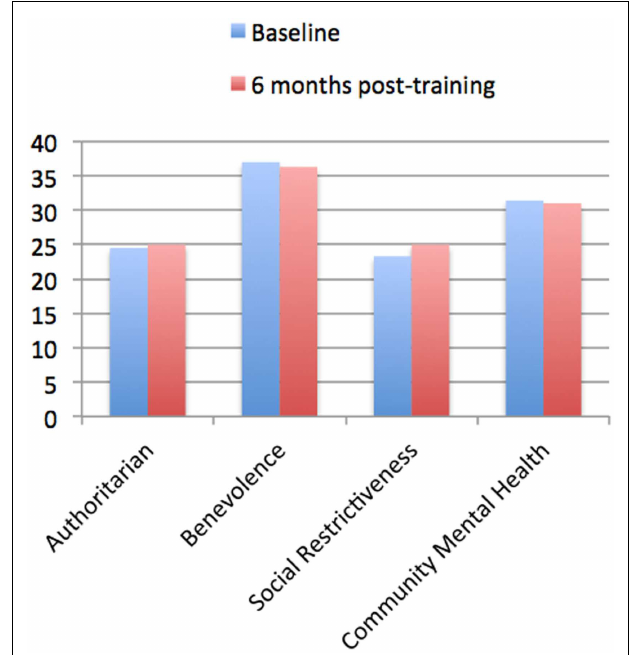
FIGURE 1 | CommunityAttitudes toward Mental Illness (CAMI) questionnaire at Baseline vs. 6months post-training. The results for the CAMI questionnaire are shown for police officers who completed both baseline and 6-month follow-up ratings ( n = 170). Four subscales of the CAMI were used which measure attitudes toward the mentally ill; the “Authoritarian” subscale measures pessimistic attitudes, the “Benevolence” subscale measures compassion and empathy, the “Social Restrictiveness” subscale measures the level individuals feel that people with mental illness are dangerous and threatening, while the “Community Mental Health Ideology” subscale determines the level of acceptance toward deinstitutionalization and attitudes toward having mental health facilities in the community. Higher scores on “Authoritarian” and “Social Restrictiveness” signify greater amounts of stigma, while higher scores on “Benevolence” signifies lower stigma and a higher score on “Community Mental Health Ideology” signifies higher acceptance of the mentally ill. Data are shown at “Baseline,” i.e., before police officers were trained, and these are compared to “6months post-training.” Community samples reported in the literature, defined as “controls” from Finkelstein et al. (2008) are 25 (CAMI-A), 40.9 (CAMI-B), and 26.3 (CAMI-SR) respectively. No control data is available for CAMI-CMHI. It can be noted that the police officers ratings appear similar (and slightly lower) than those of the community Controls, and there appear to be possibly slightly lower stigma in police officers compared to community